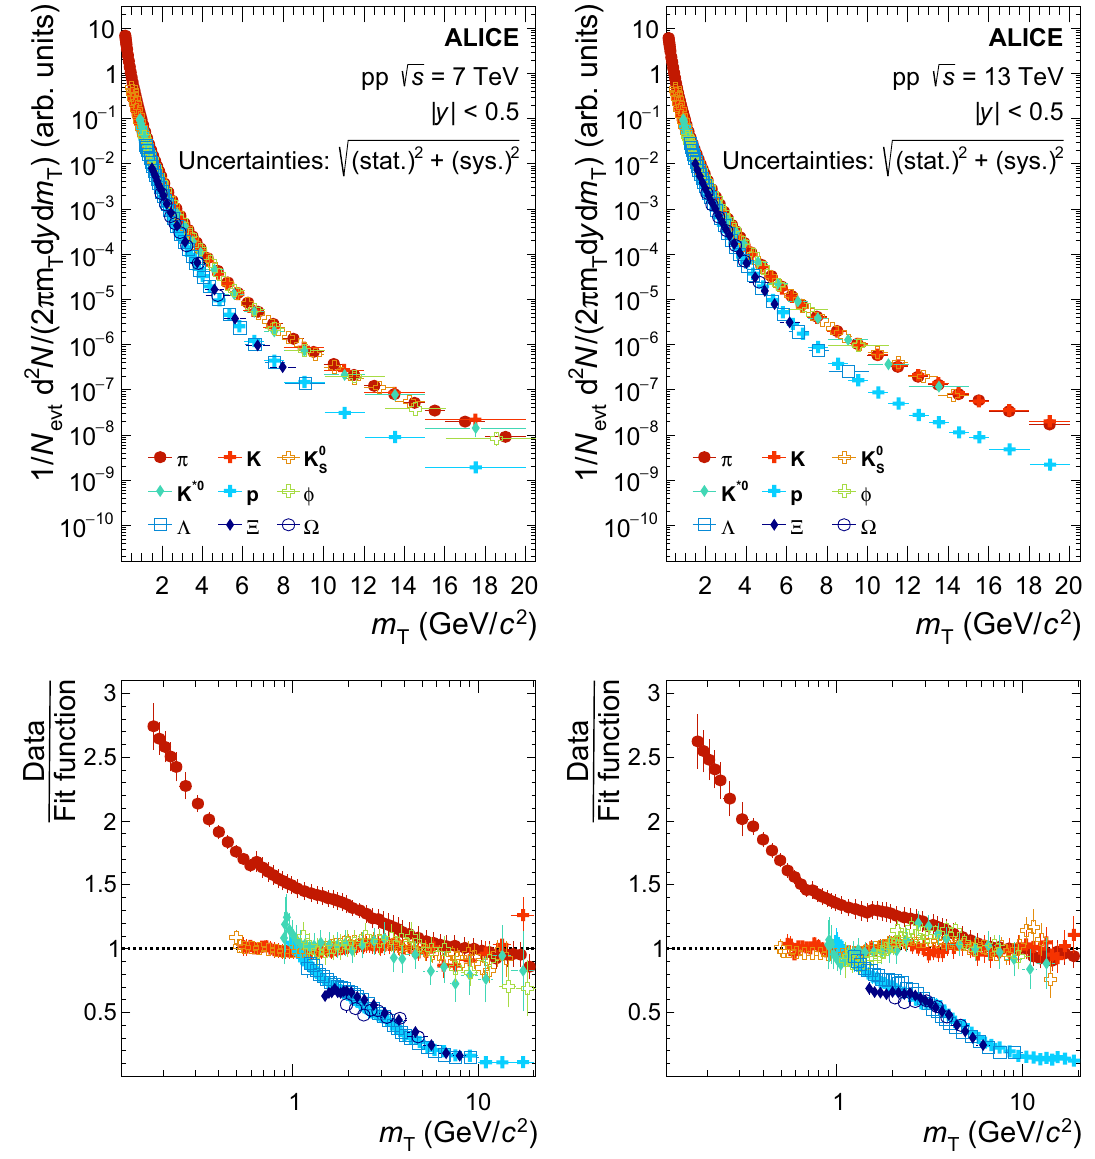
√ s = 7 TeV (left) and 13 TeV (right). Lower panels: Ratios of √ s = 7 TeV are from Refs. [25,27,60]